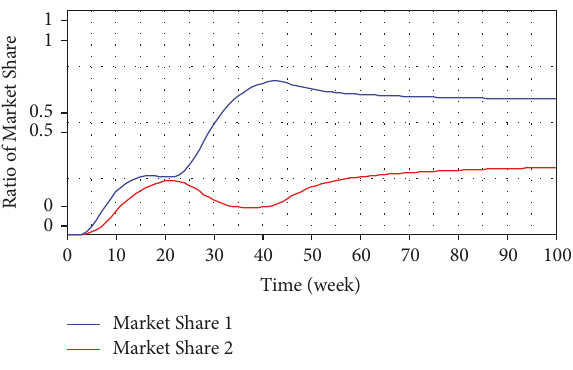
Figure 9: Market Share contrast 1.